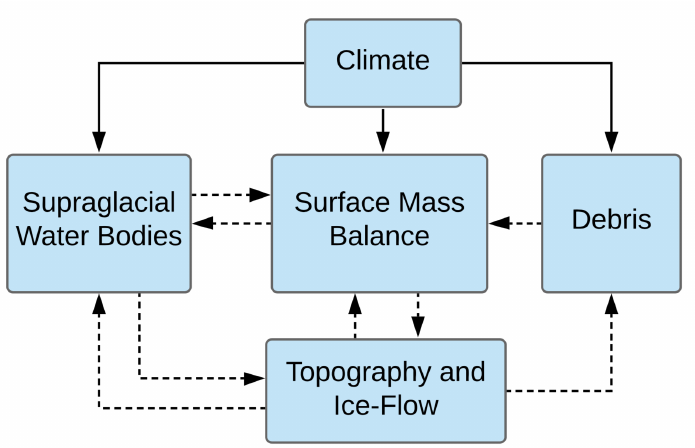
Figure 6. Major system couplings and and feedbacks (dashed lines) that govern surface processes on a debris-covered glacier. Positive feedbacks, such as the one between surface mass balance, supraglacial water bodies, and topographic condition, play a critical role in the system as they may be responsible for the high-magnitude ice loss observed on many debris-covered